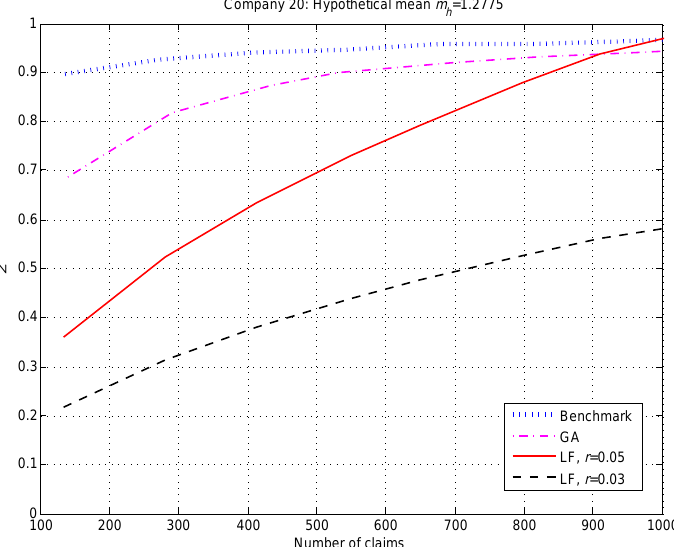
Figure 3. We contrast the Benchmark, GA, and LF credibility factors for “company” (risk class) 20, whose hypothetical mean is m 20 ≈